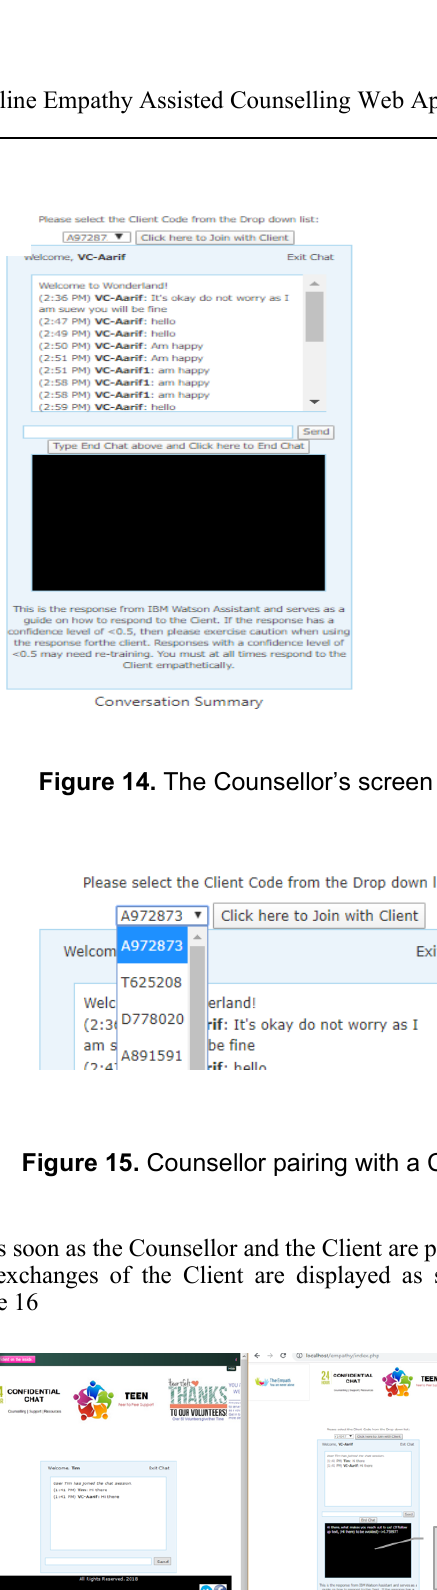
Figure 16. Chat exchanges displayed on the Client and counsellor